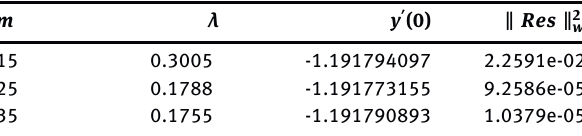
Table 2: Obtained values of y ′ (0) by the present method for various values of m , β = 0.50 , and α = 0.50